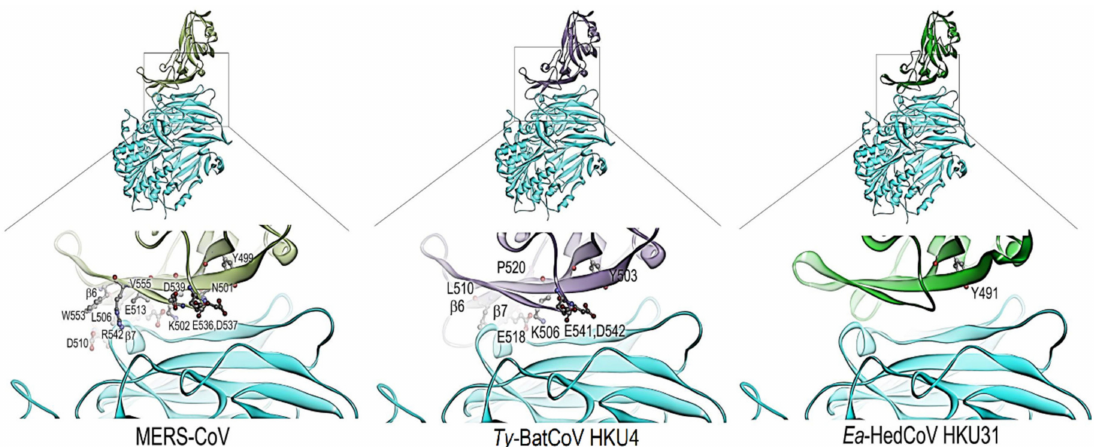
Figure 4. The models of receptor-binding domains (RBDs) of MERS (pea green), HKU4-4 S (purple) and HKU31-F6 S (green) are shown with hDPP4 structure (light blue) in ribbon diagram. The interface of di ff erent RBDs and hDPP4 are zoomed into and the residues that were highlighted in multiple sequence alignment from Figure 5 are shown in ball-and-stick format, colored by element (carbon, gray; nitrogen, blue; oxygen, red). Strands of β 6 and β 7 are present in the structure of MERS and HKU4-4S only. The figures were produced using Discovery Studio visualizer (Accelrys).